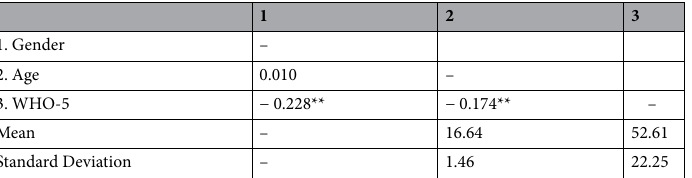
Table 1. Summary of descriptive statistics and zero order correlations between demographic characteristics and levels of well-being. *p < 0.01, **p < 0.001, N =